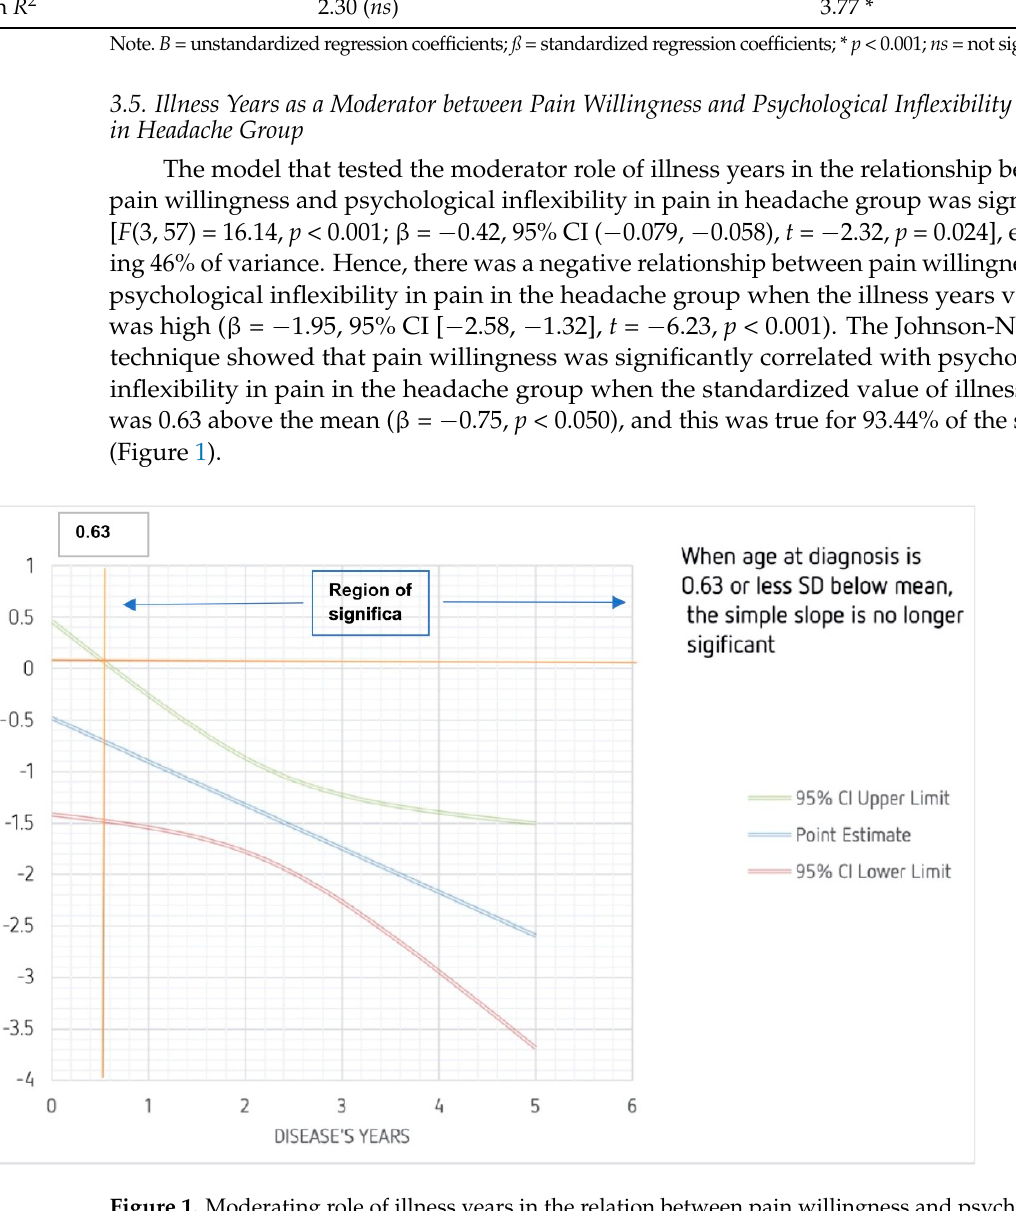
Figure 1. Moderating role of illness years in the relation between pain willingness and psychological inflexibility in pain in headache group.